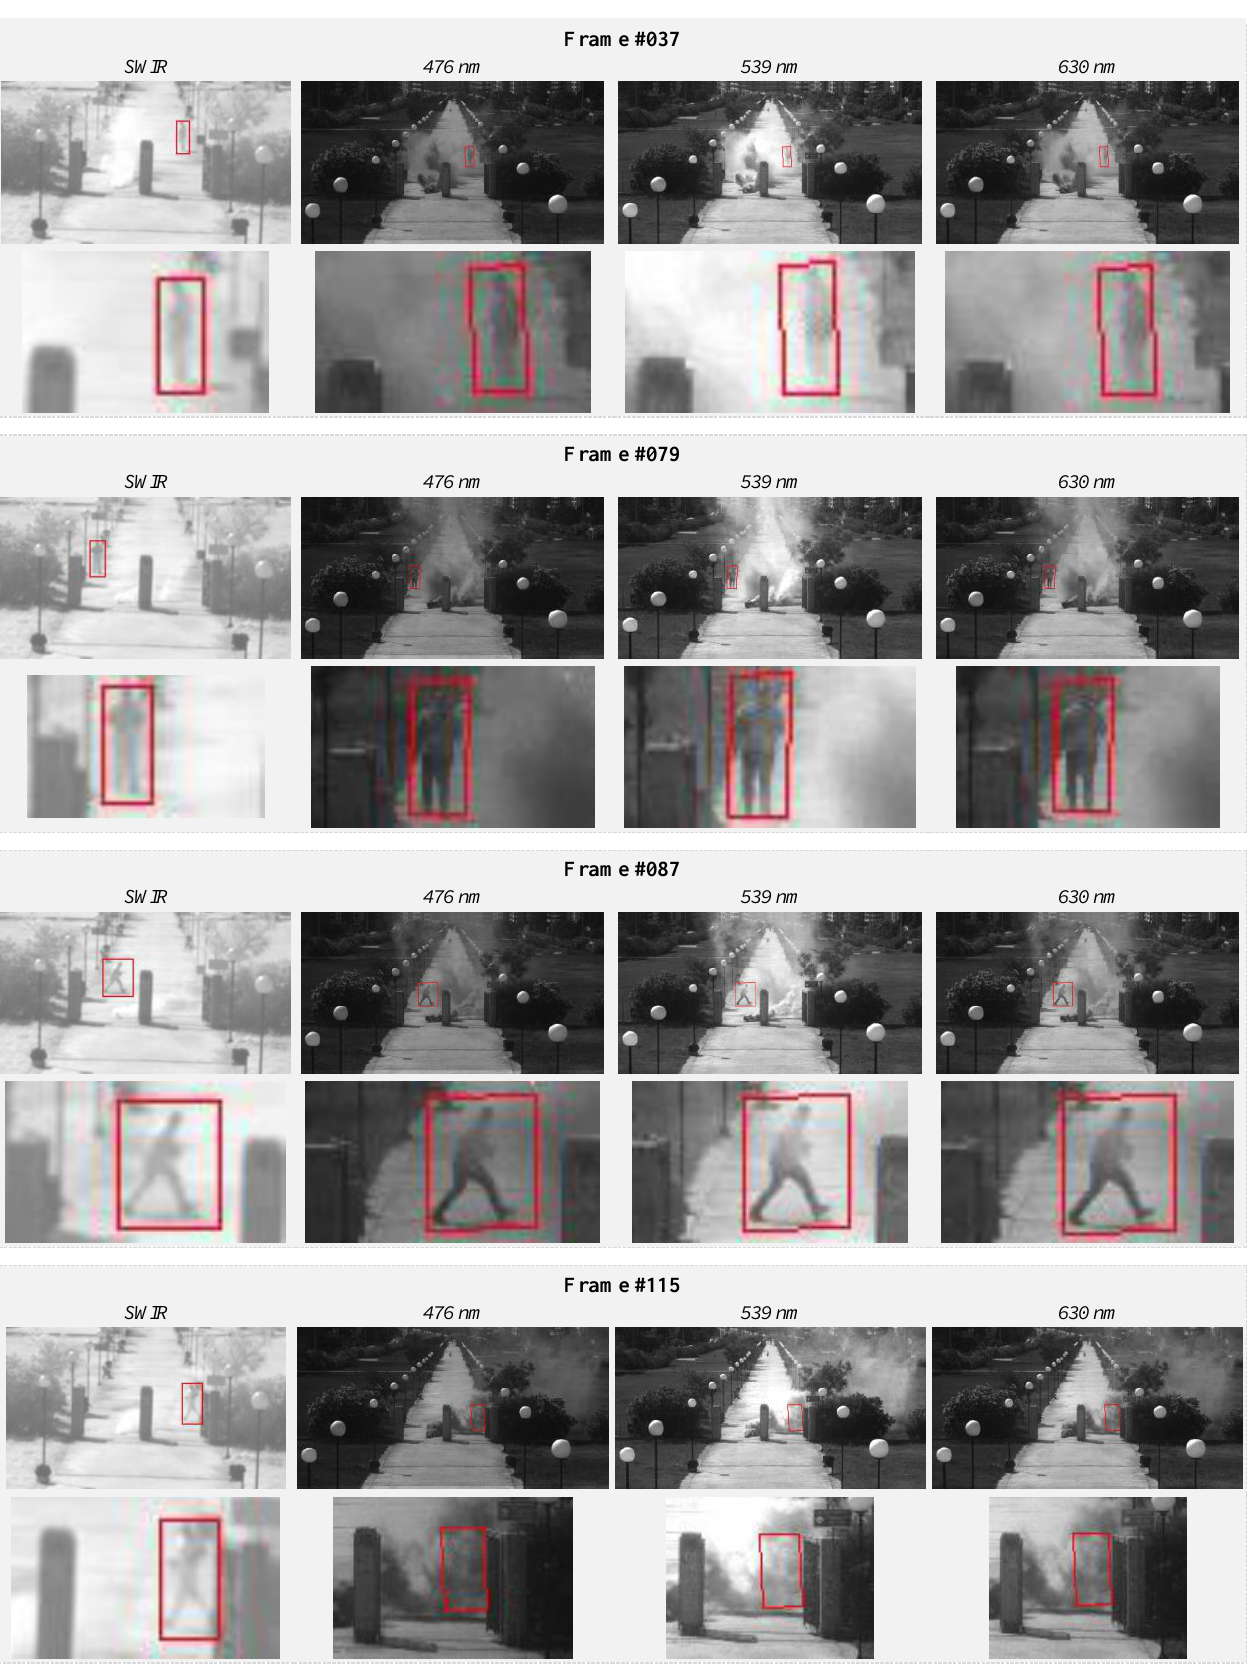
Figure 6: Experimental results after the application of the developed system. The indicative frames number #037, #079, #087 and #115 are shown. For each frame the SWIR and three hyperspectral bands (476, 539, 630 nm) are presented. The detected targets are annotated with a red color onto the SWIR. Their projections are also shown onto the hyperspectral images. Zoom-in views are, also,